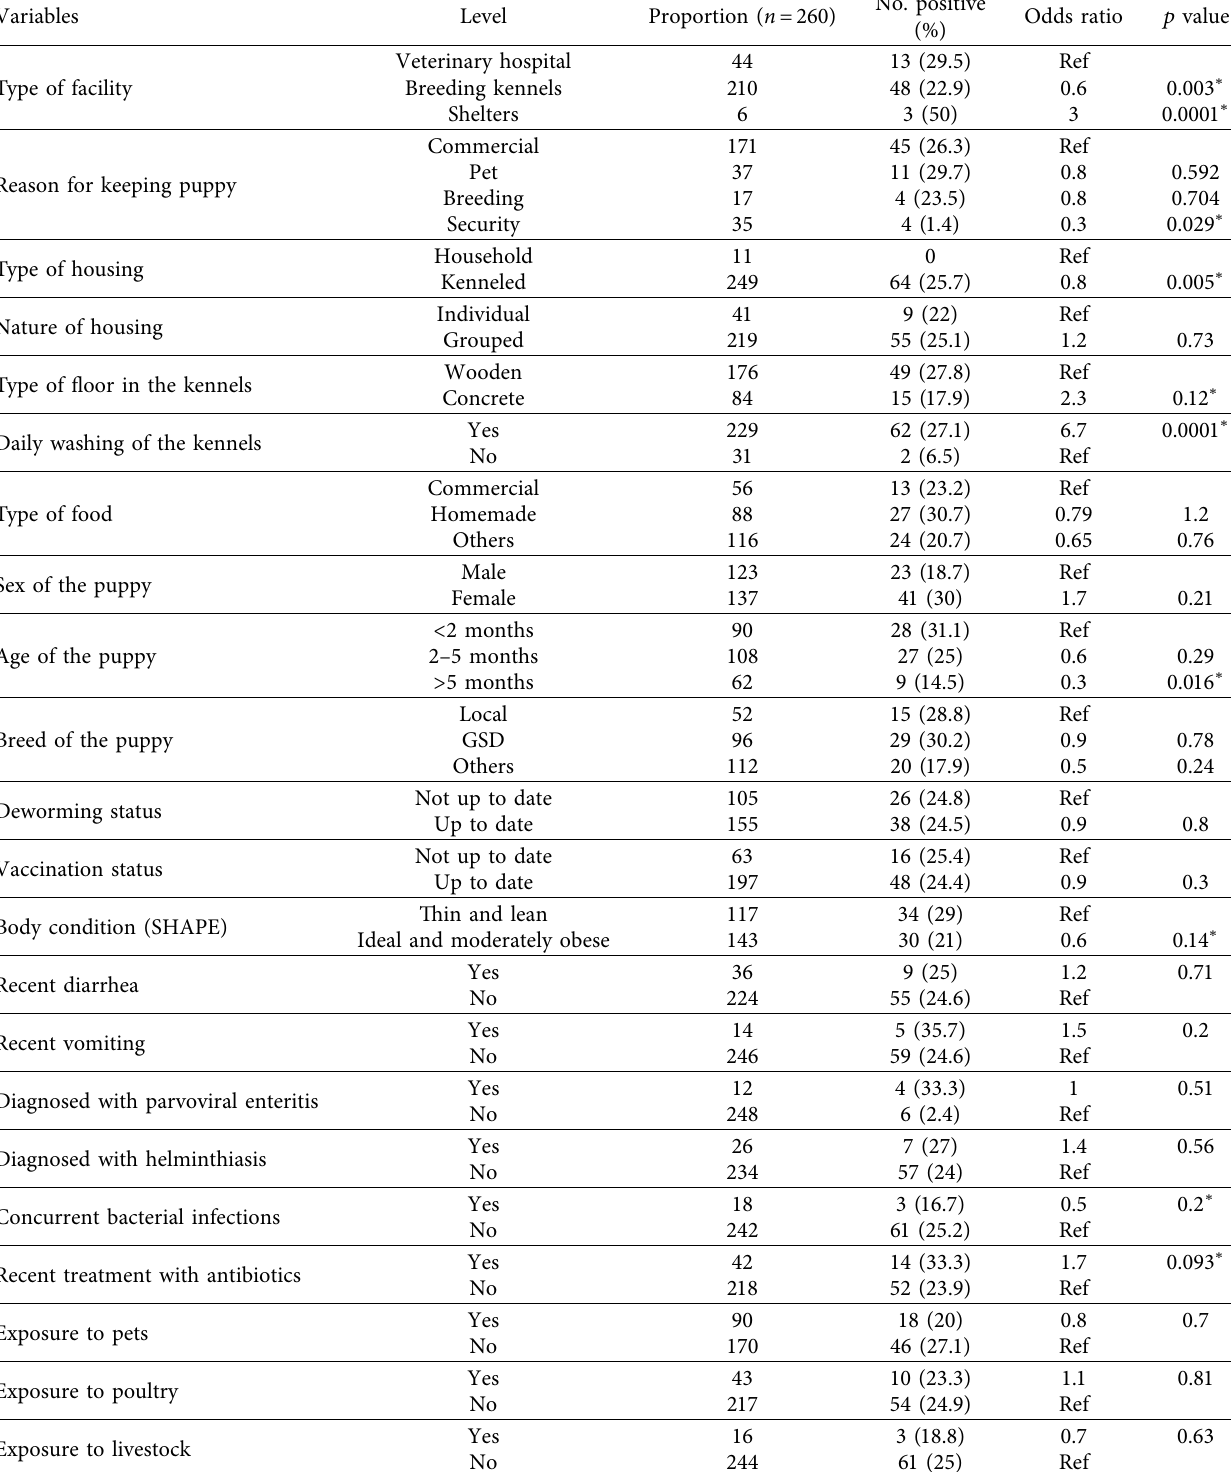
Table 1: Descriptive statistics of variables and univariable logistic regression analysis of potential risk factors for puppy Campylo- bacter species positivity ( p ≤